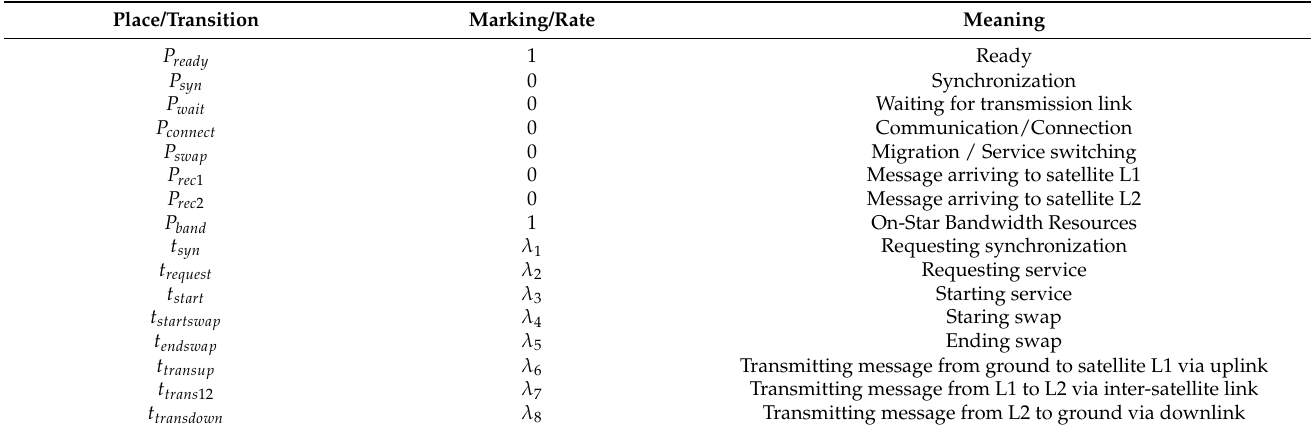
Table 4. List of SPN objects in Figure 8.